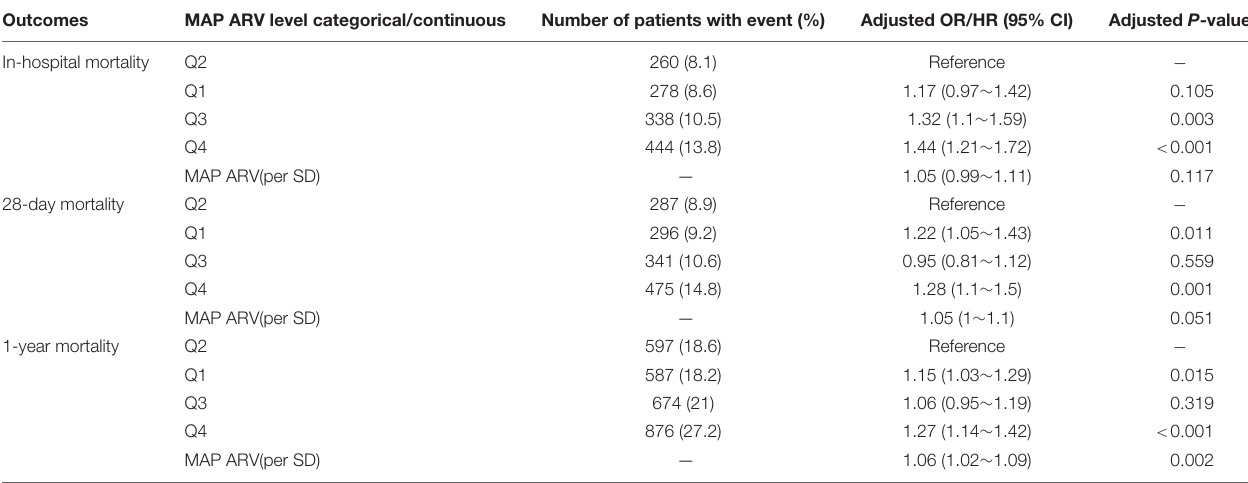
ARV, average real variability; MAP, mean arterial